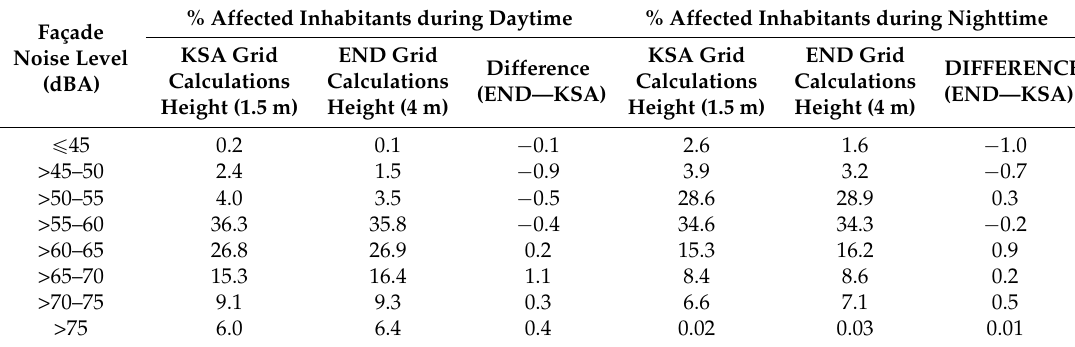
Table 6. Distribution of inhabitants in relation to day and night façade noise levels: comparing results of calculation based on Saudi and END recommended grid calculations